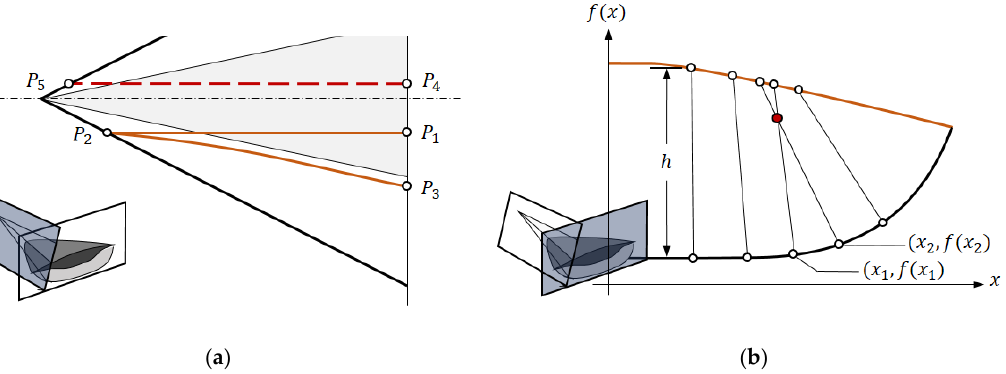
Figure 2. Geometric relationships in the osculating cone theory : ( a ) Geometric constraint based on the position of the cone center; ( b ) Geometric constraint based on the intersected planes.